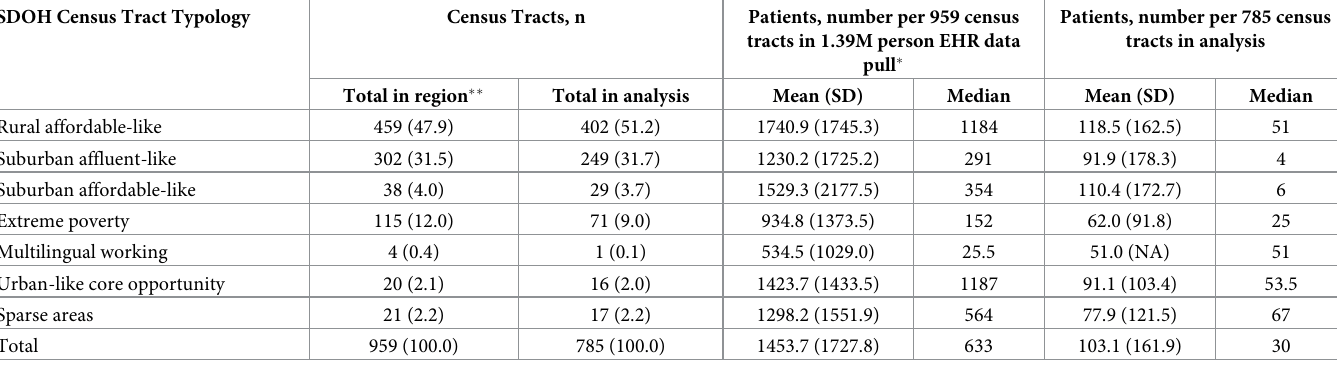
Table 2. Census tracts in region and census tracts and patients in analysis. SDOH Census Tract